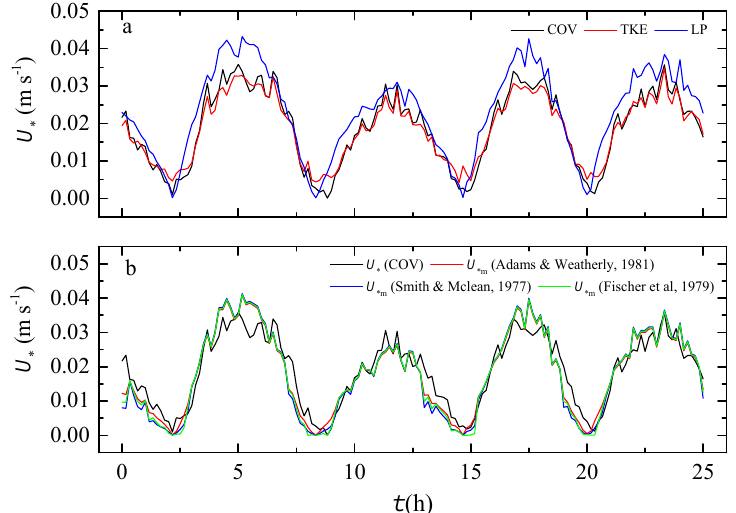
Figure 6. Time series of the friction velocity ( U * ). ( a ) U * estimated from the LP, COV, and TKE method; ( b ) U * estimated from the COV method and the modified friction velocity ( U *m ) from the Adams and Weatherly (1981), Smith and McLean (1977), and Fischer et al. (1979) methods (Equations (21)–(23)). The time series of U * estimated from the method of LP (based on the tidal averaged Z 0 of 1.34 × 10 − 3 m and the burst averaged velocity measured at 1 m asb), COV (based on the high ‐ frequency velocity measured at 0.2 and 1 m asb), and TKE (based on the high ‐ frequency velocity measured at 0.2 and 1 m asb) are shown in Figure 6a. The COV and TKE methods have consistent results, and the LP method significantly overestimated U * .